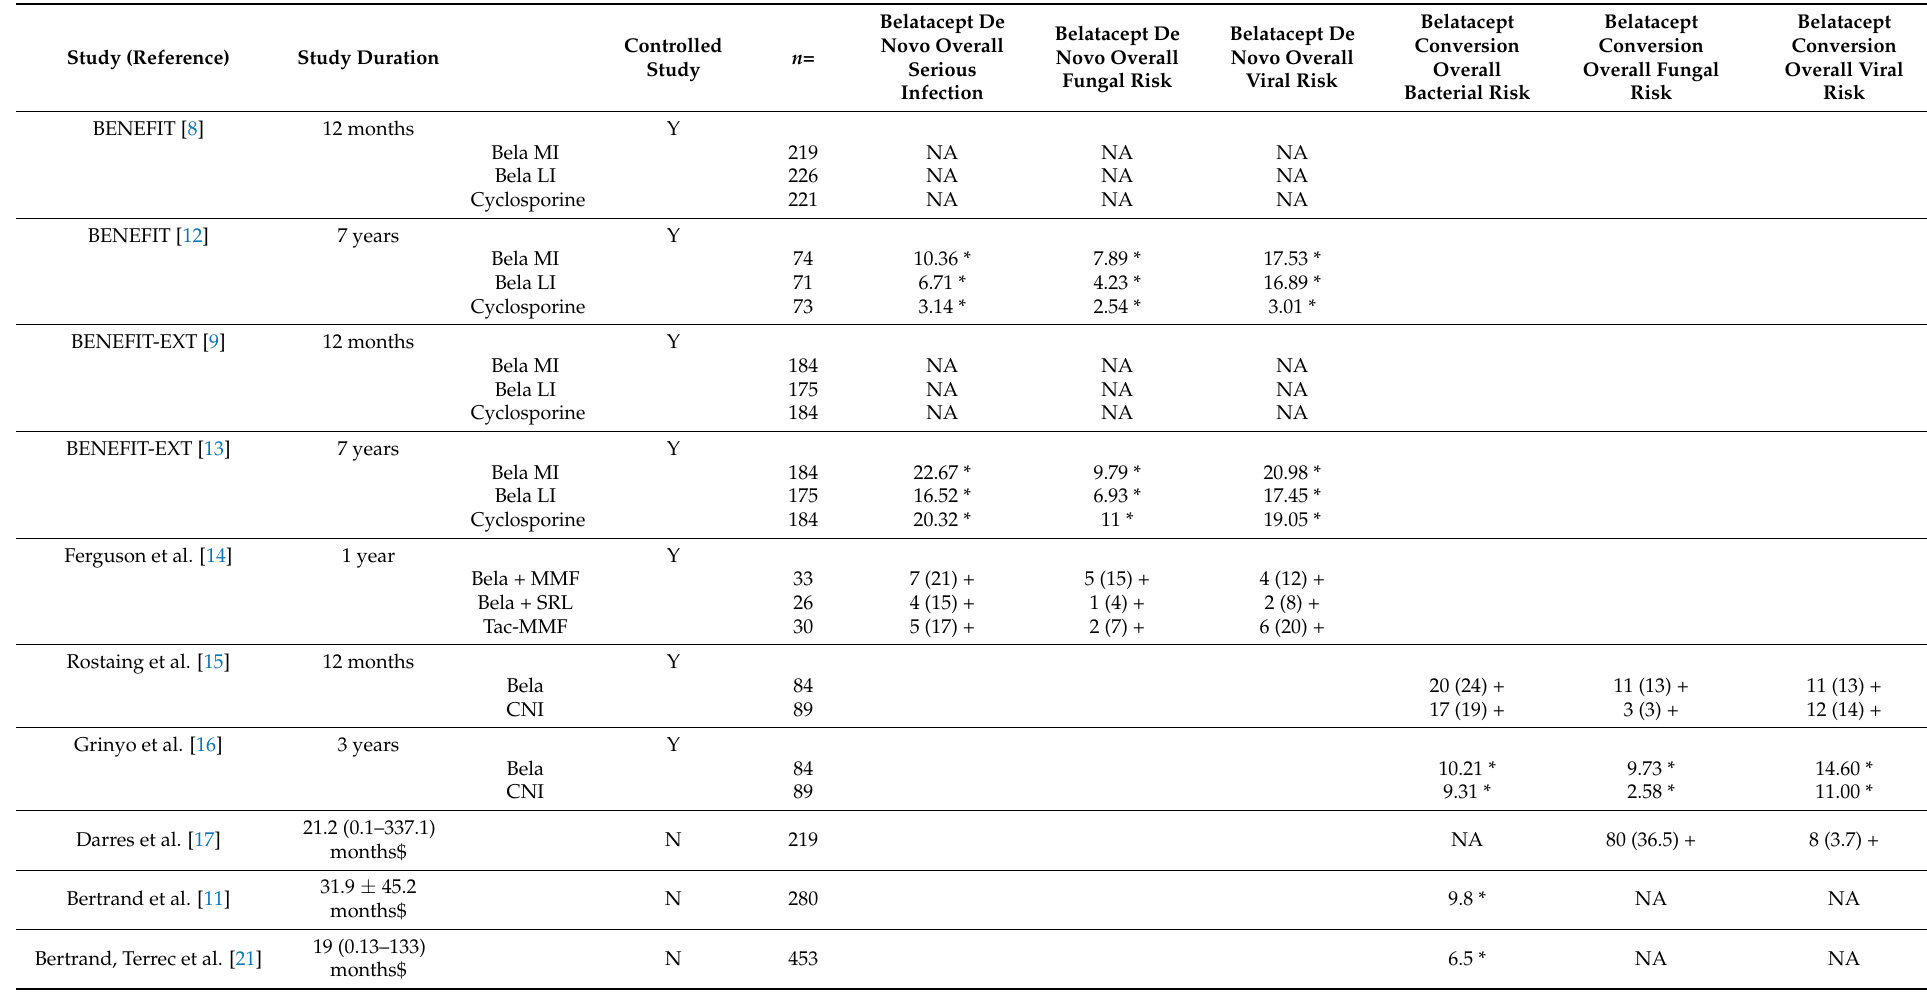
Table 3. Overall risks for serious, fungal, viral, and bacterial